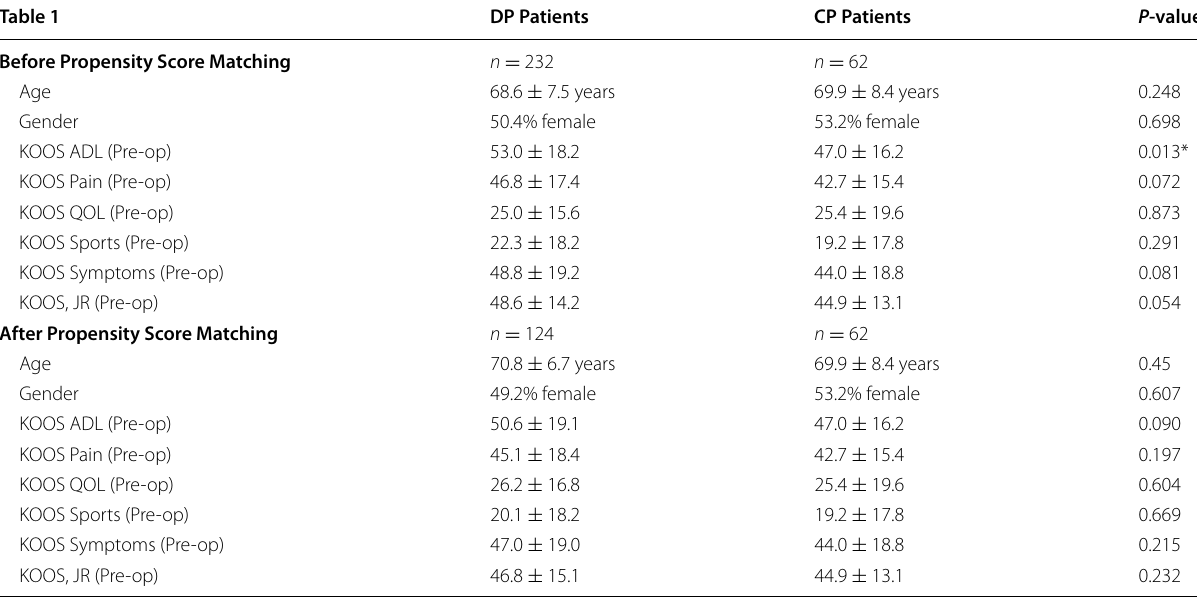
Table 1 Patient information and preoperative KOOS and KOOS, JR scores before and after propensity score matching DP Patients CP